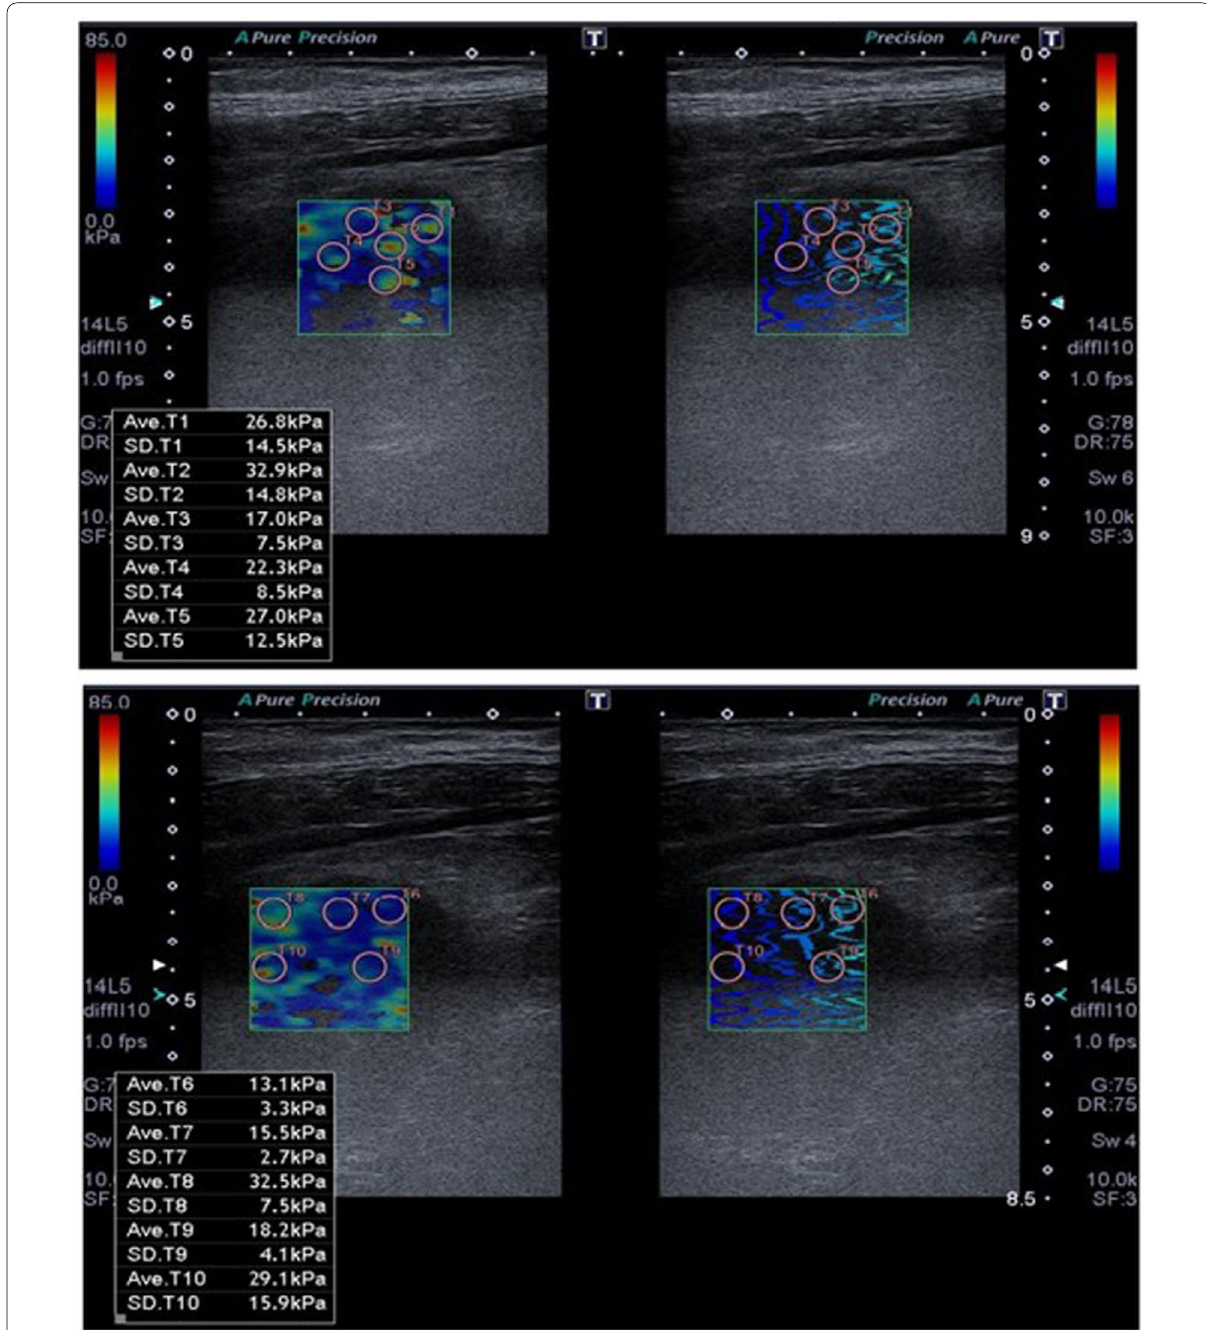
Fig. 2 Shear wave elastography stiffness values in kPa in case of chronic allograft nephropathy. Legend : Mean stiffness value of the transplanted kidney 23.44 kPa. Pathology revealed mild interstitial fibrosis and tubular atrophy (IFTA Grade I,